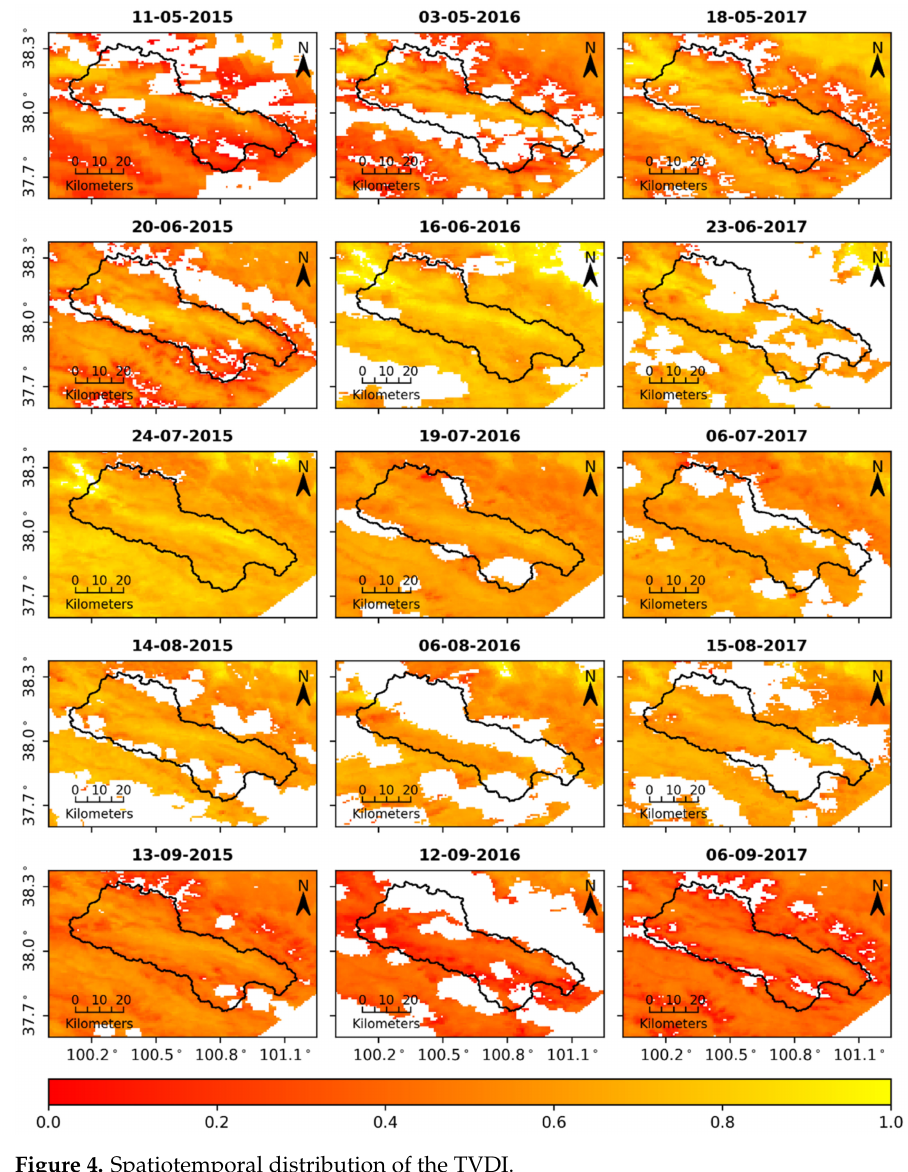
Figure 4. Spatiotemporal distribution of the TVDI.